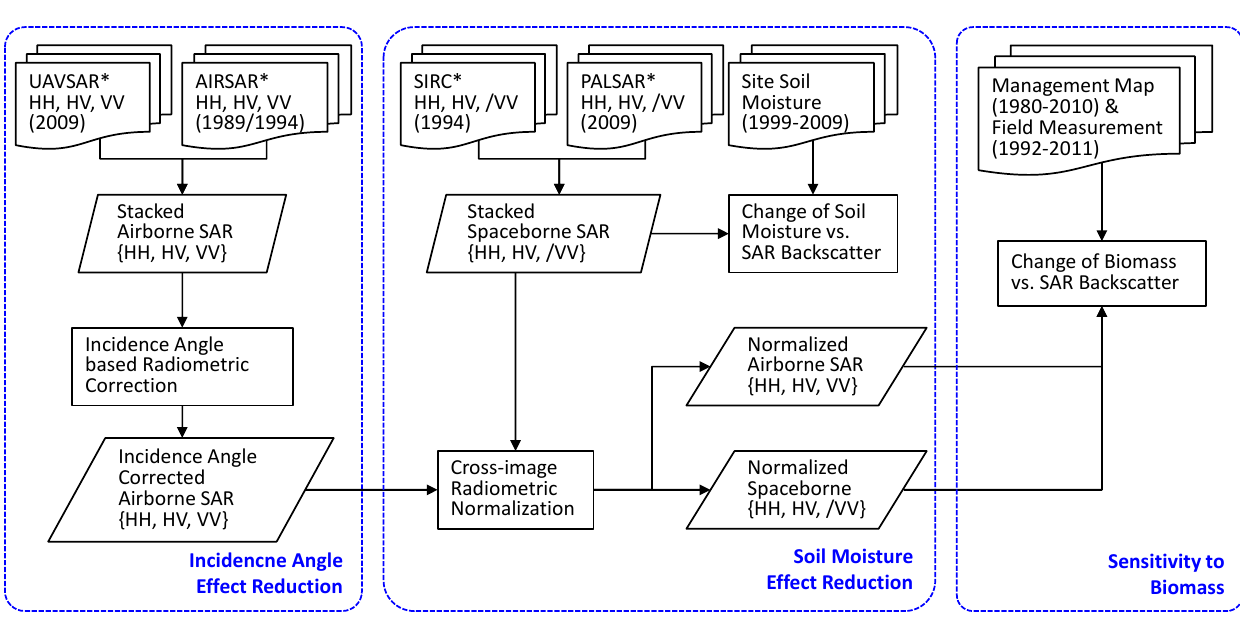
Figure 2. Flowchart of SAR data processing and sensitivity